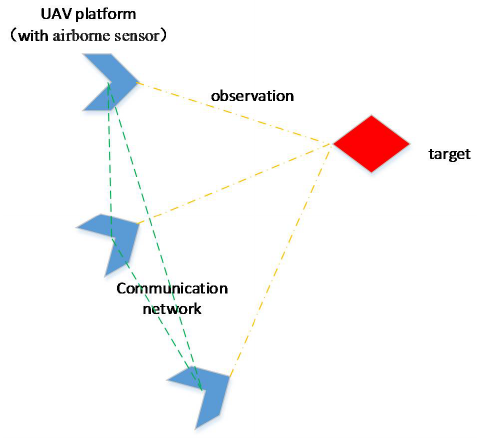
Figure 1. Cooperative target tracking. UAV: Unmanned Aerial Vehicle.